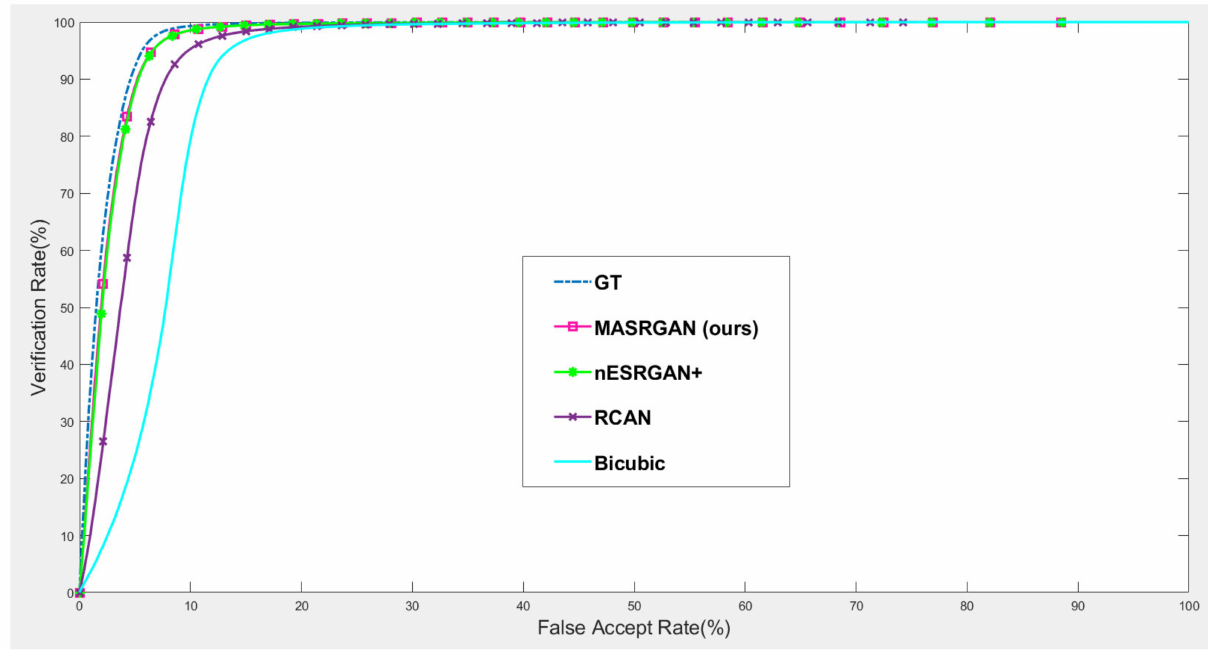
Figure 15. The comparison of the ROC curves of face recognition based on input images enhanced by the various SR models on CelebA